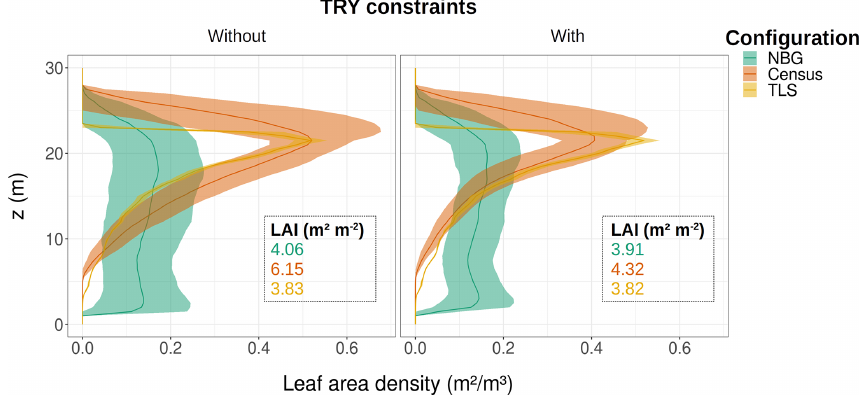
Figure 7. Ecosystem average of the leaf area density vertical distribution for the month of June for different model configurations (coloured lines and envelopes) without (left) and with (right) TRY constraints on SLA and V c , max . The envelopes encompass the mean ± one standard deviation of the ensemble member runs. Only runs that generated vegetation were kept when plotting the NBG envelopes. The settings of the model configurations are detailed in Table